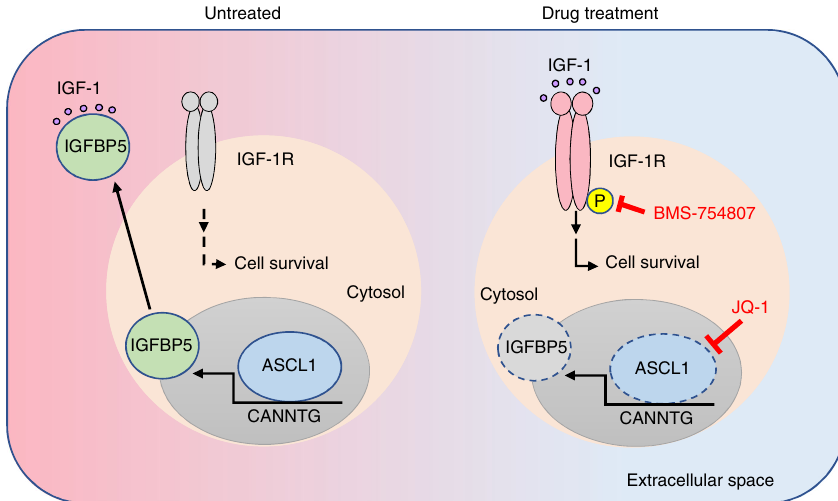
Fig. 6 ASCL1 orchestrates an IGFBP5-dependent mechanism to suppress IGF-1 signaling. Under basal conditions, ASCL1 promotes the transcription and expression of IGFBP5, which accumulates in the extracellular space. In doing so, IGFBP5 inhibits IGF-1 from binding to its cognate receptor (IGF-1R). JQ-1- treatment leads to the downregulation of ASCL1 and subsequently, IGFBP5. This de-represses IGF-1 signaling and renders the cells more sensitive to IGF-1R inhibitors. This model suggests that a combination of JQ-1 and IGF-1R inhibitors might be more effective in killing ASCL1 High NE-lung